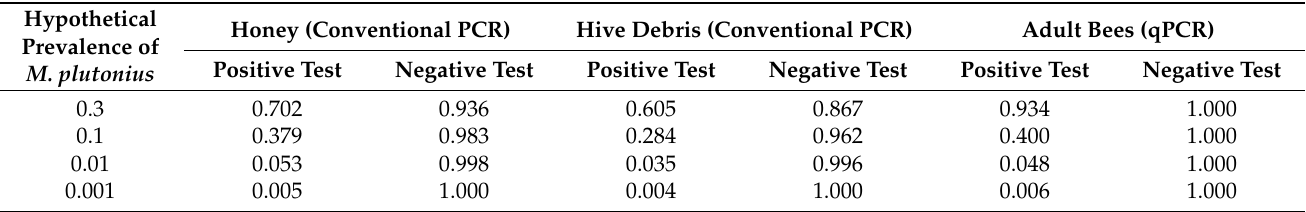
Table 4. Predictive values for the positive and negative tests based on the prevalence of M. plutonius in honey, hive debris, and adult